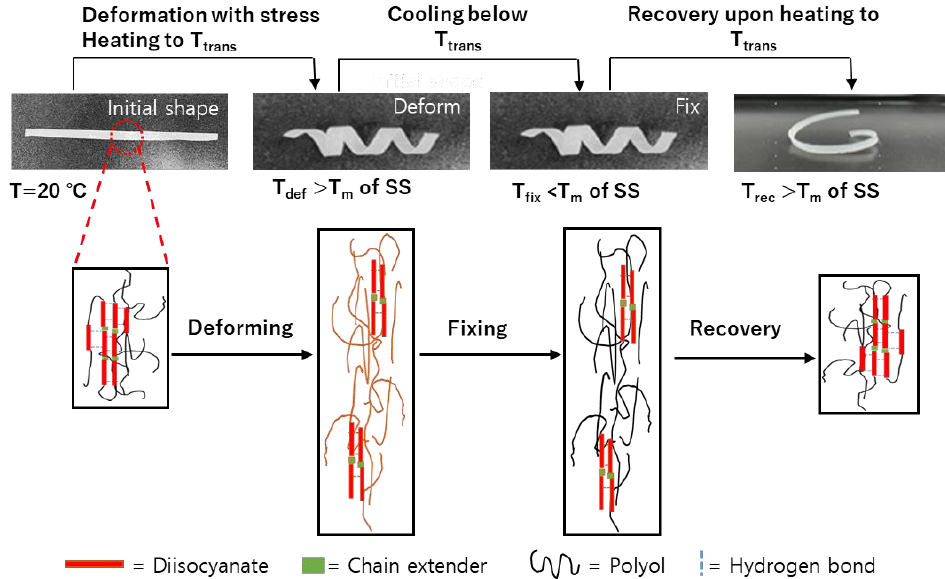
Figure 7. Shape memory cycle of the bio-based shape memory thermoplastic